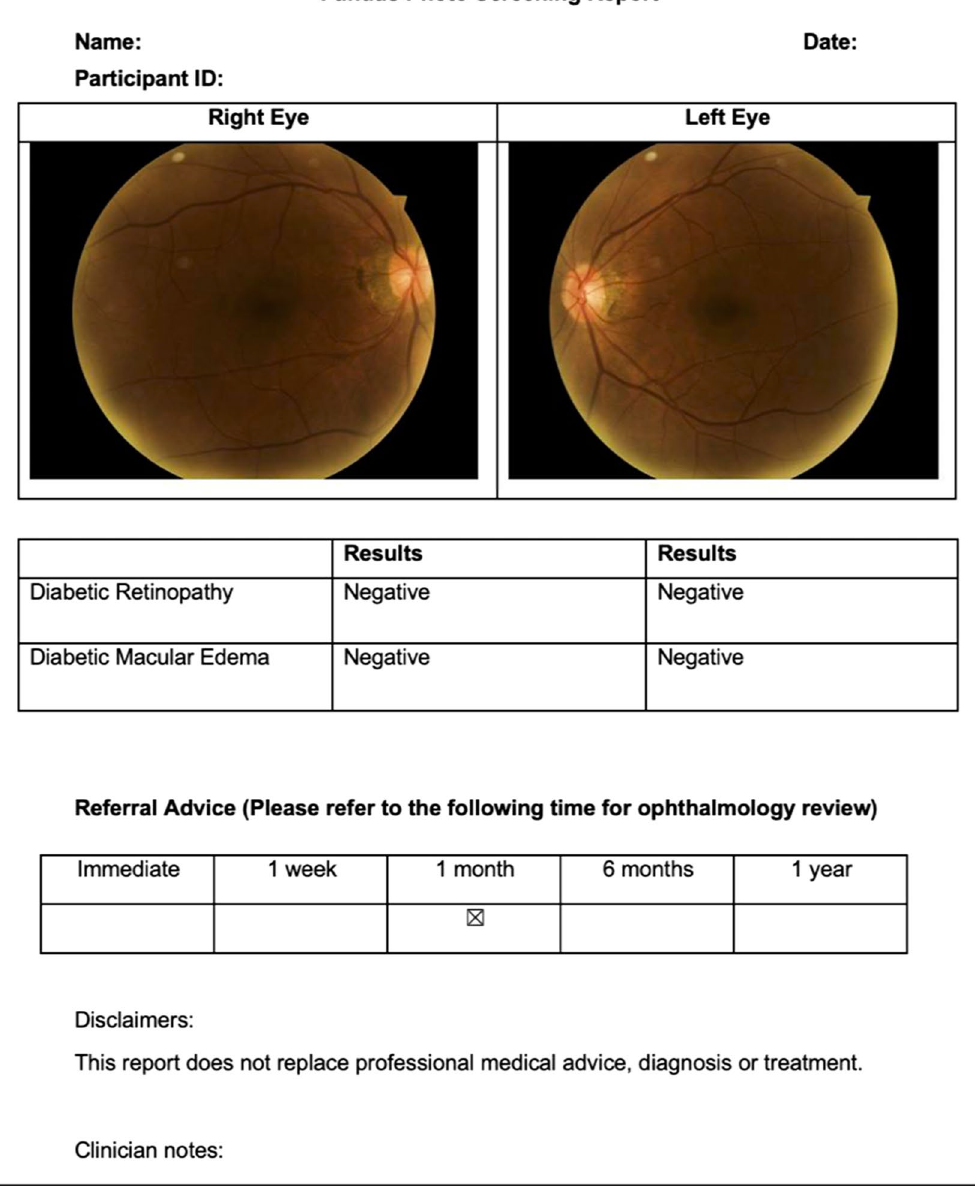
intelligence system have been described previously 11,21,22